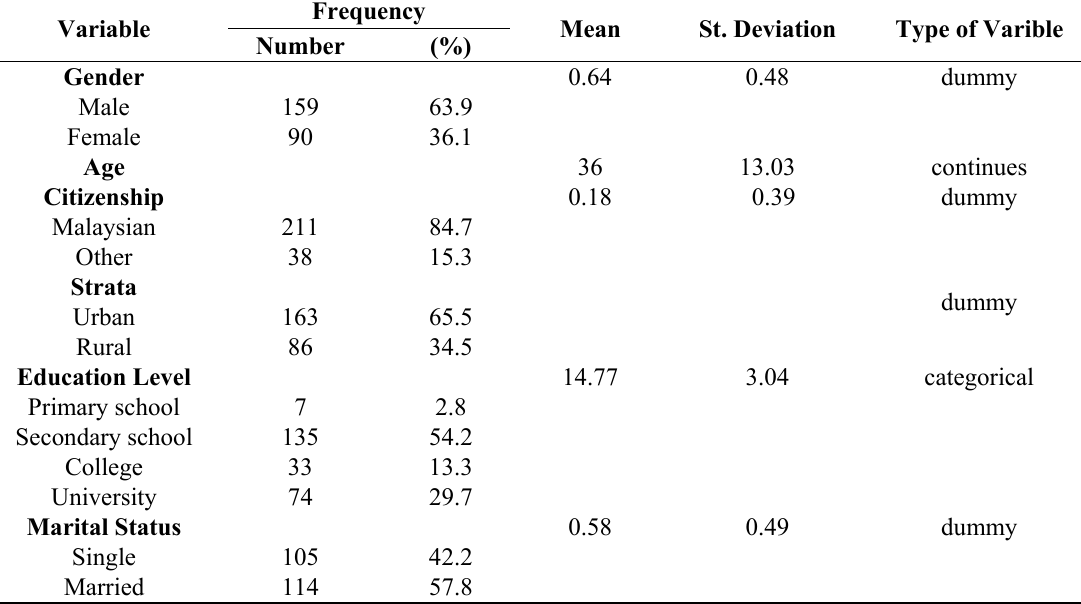
Table 3. Socio demographic characteristics of the